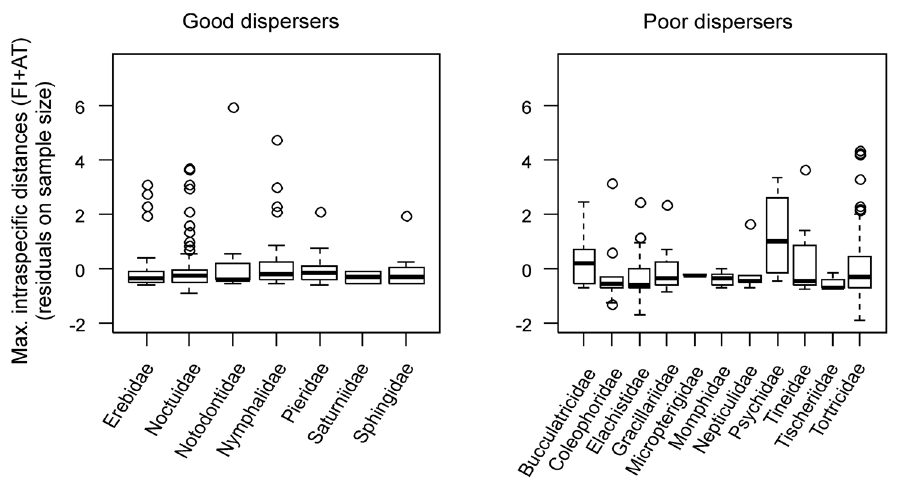
Fig. 10. Maximum intraspecific divergence compared across families with good and poor dispersal. Boxplots show the residuals from a regression of maximum intraspecific distance between Austrian and Finnish samples against sample size. Residuals are plotted to account for among-species differences in sample size, and thus allow comparisons between families.